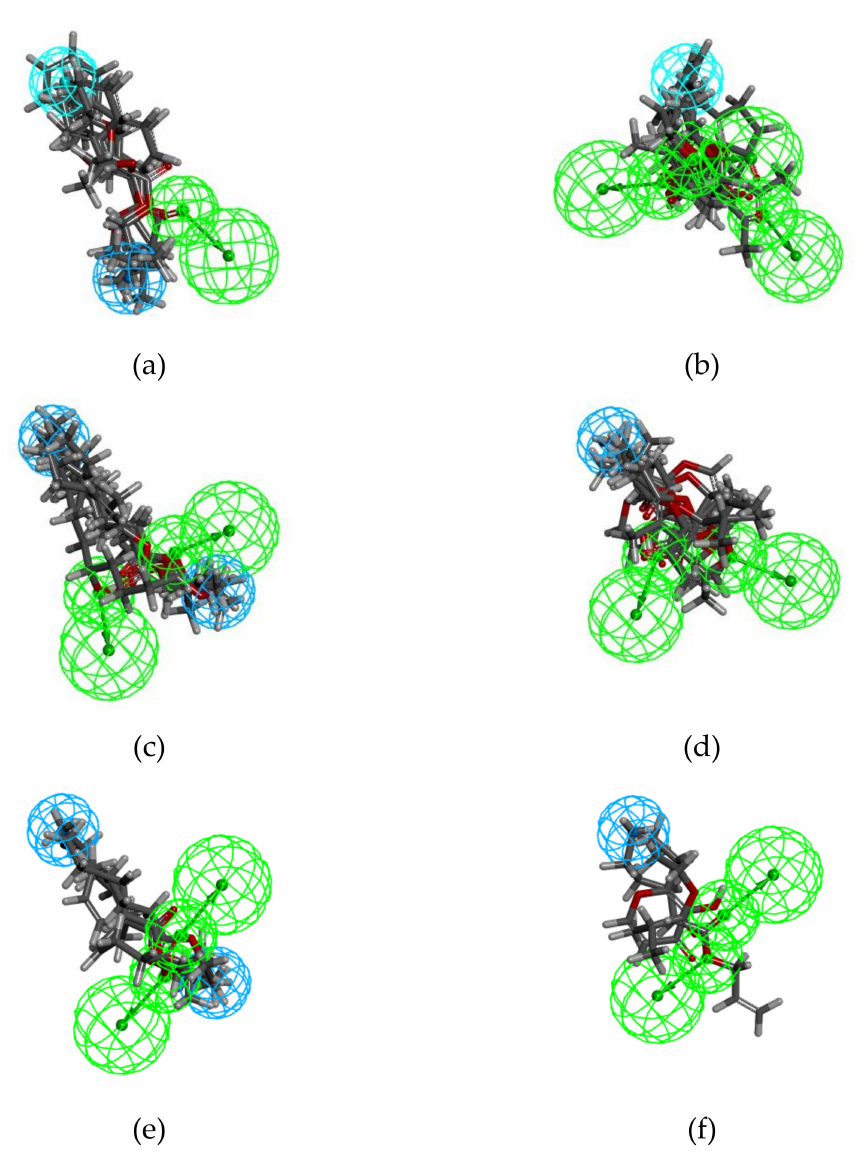
Figure8. Mapping ofthe ligands to thechemical features ofHypos_01 generated from the corresponding subsets: ( a ) t-STR; ( b ) t-CAR; ( c ) t-PNA; ( d ) STR-CAR; ( e ) STR-PNA; ( f ) and EXP. The green, cyan and light cyan spheres represent hydrogen bond acceptor (HBA and HBA-lip), hydrophobic aliphatic (Hy-al) and hydrophobic (Hy) features,